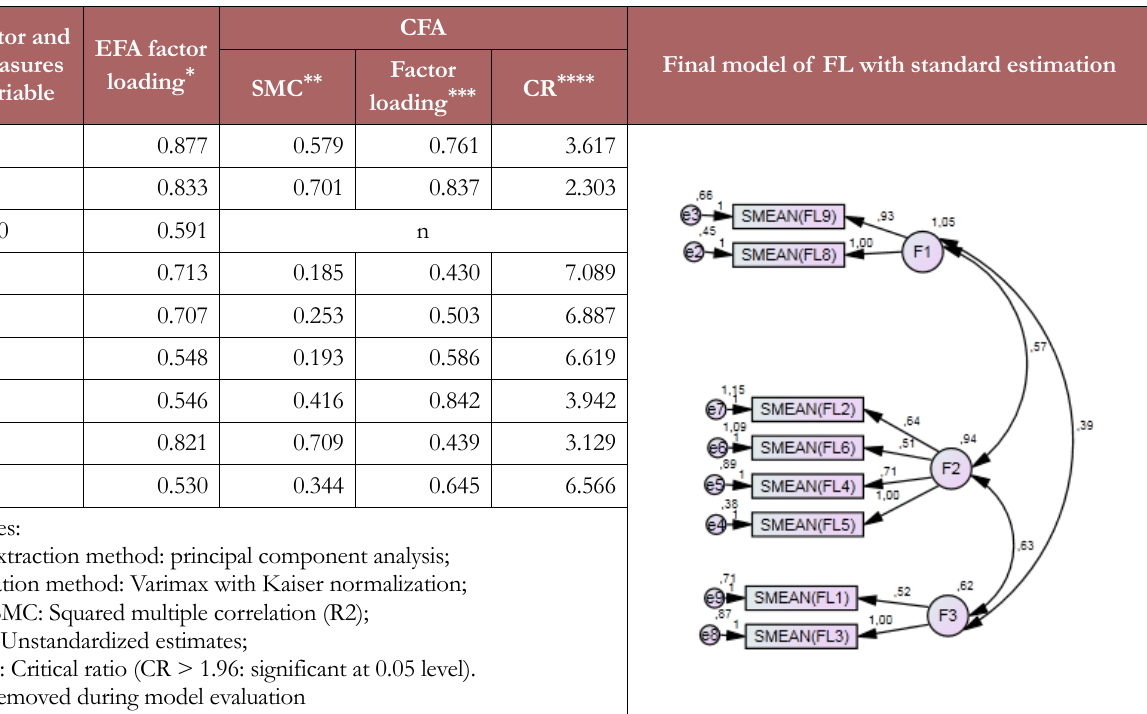
Table 15. EFA and CFA of the FL construct